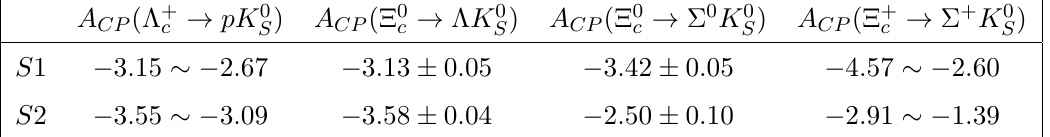
decays in the S